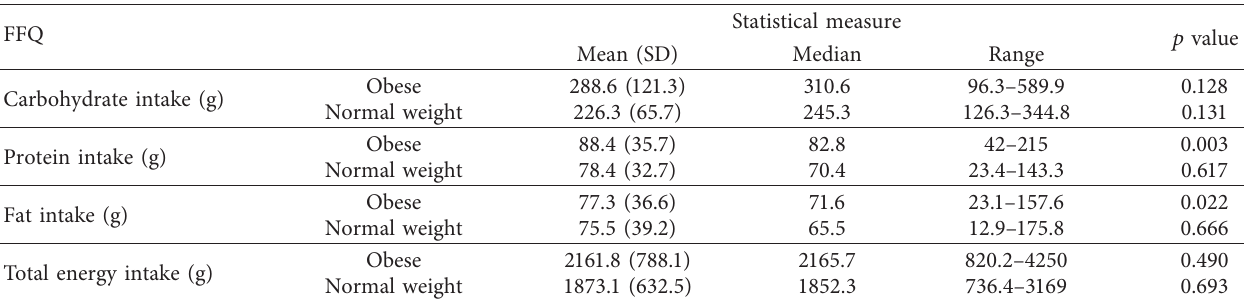
Table 2: Descriptive statistics of macronutrient intake based on the FFQ in both obese and normal-weight individuals.